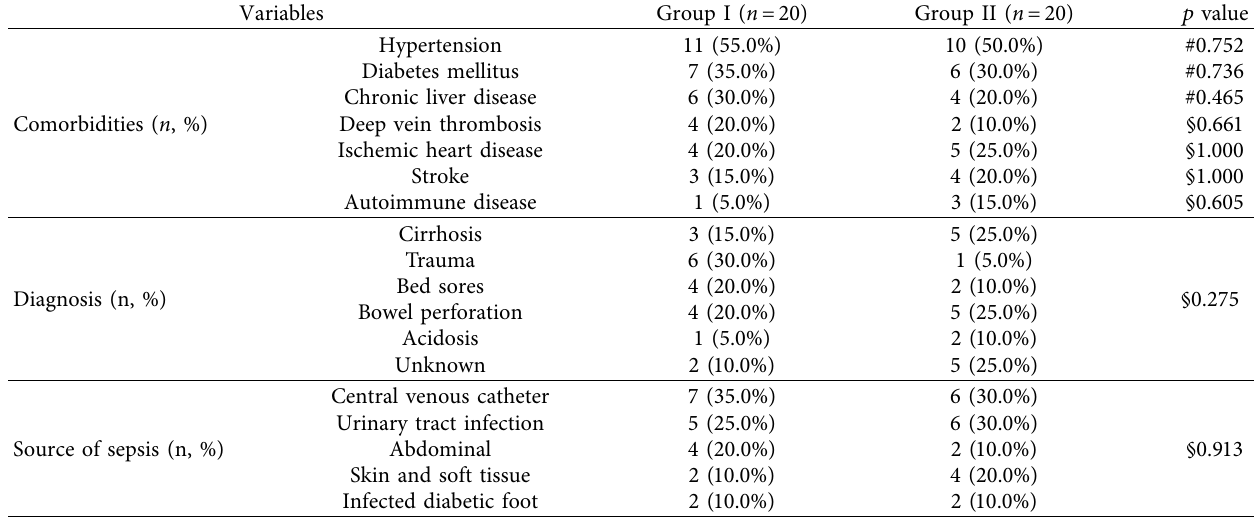
Table 2: Comorbidities, diagnosis, and source of sepsis between the study groups.